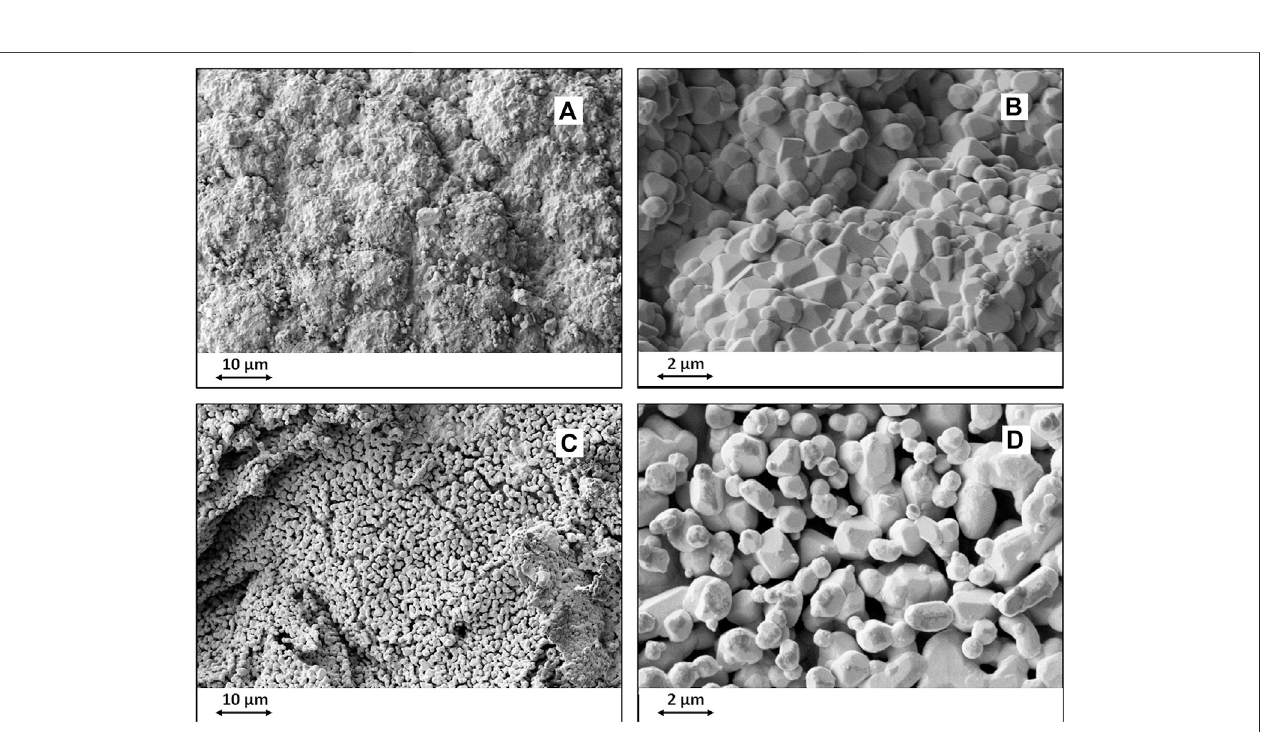
FIGURE 2 | SEM images of biomorphic CaC 2 obtained by heterogeneous Ca-C reaction. (A,B) : CaC 2 obtained at ∼ 1,500 ° C; (C,D) : CaC 2 obtained at T < 900 ° C. (A,C) : overall biomorphic microstructure; (B,D) : detail showing the grain size and morphology.